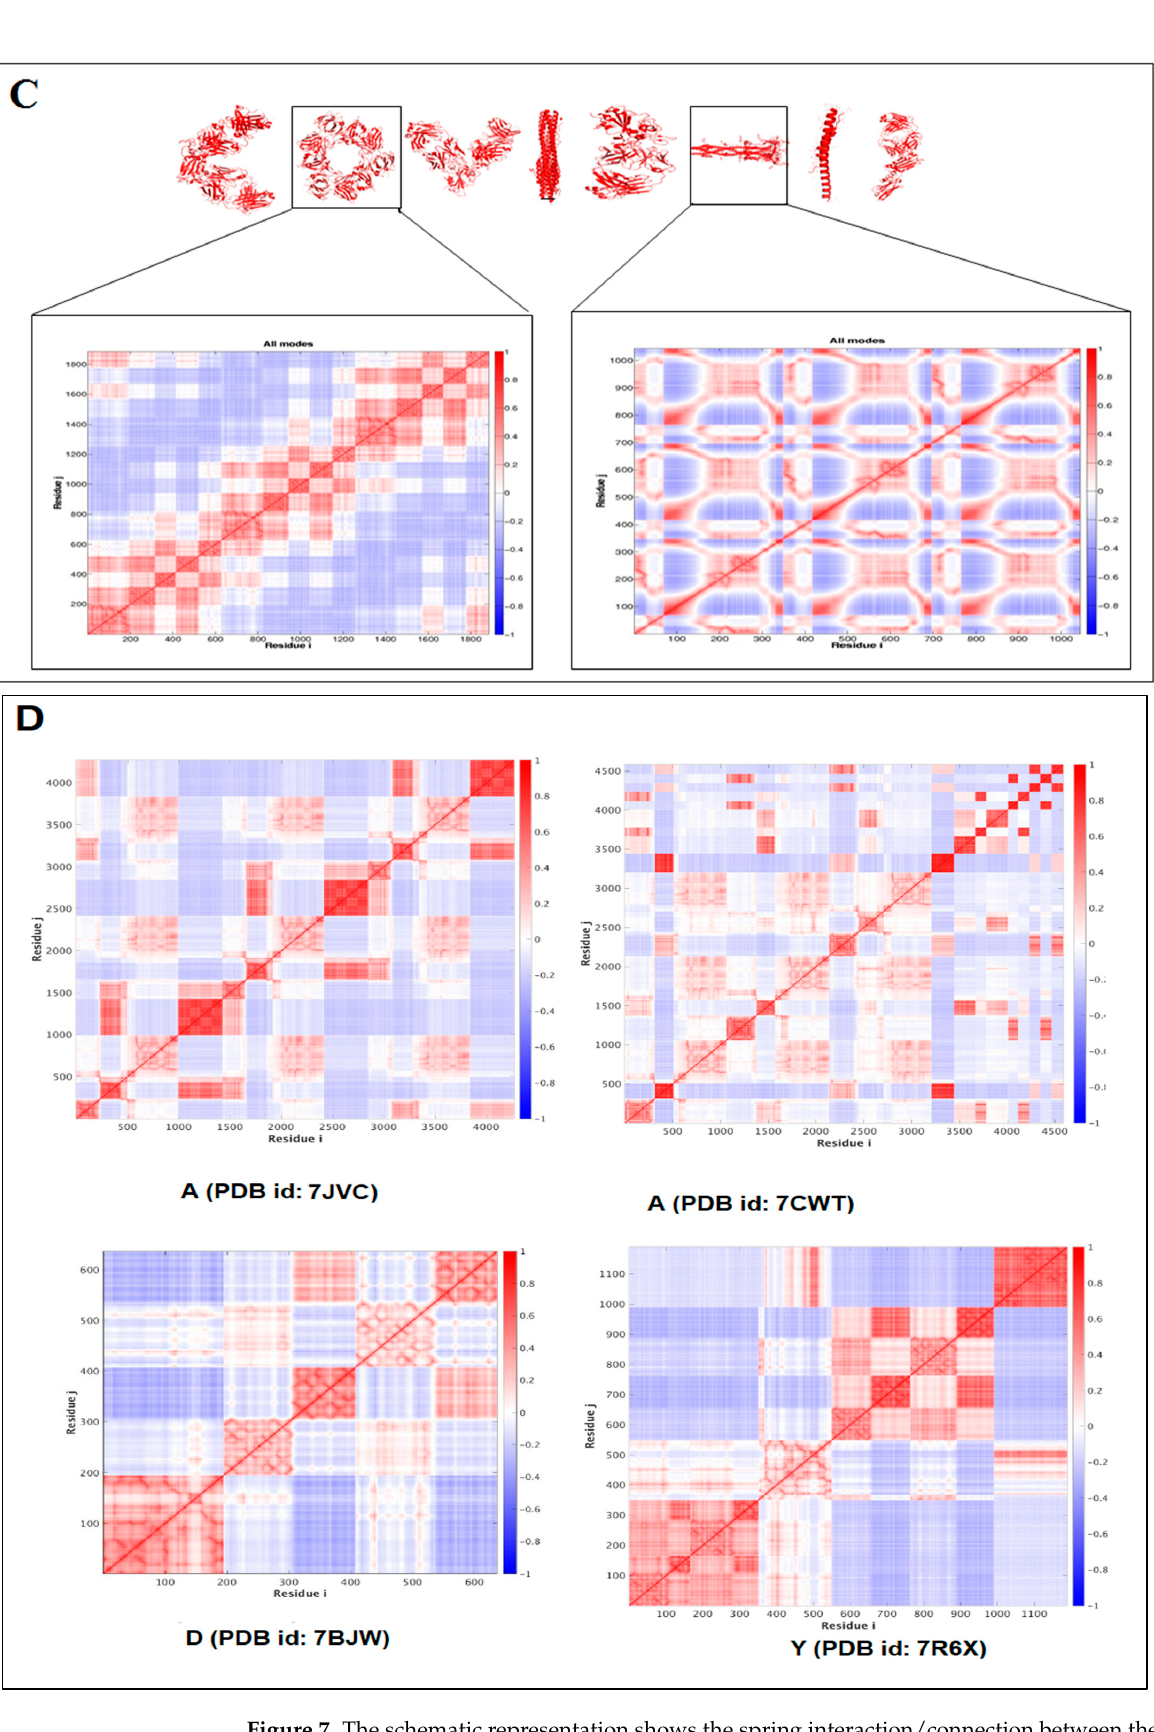
Figure 7. The schematic representation shows the spring interaction/connection between the pair of interest nodes or chains and to develop a cross-correlation (CC) map from the study of SARS-CoV-2 proteins and non-SARS CoV-2 proteins. ( A ) Schematic representation of spring in- teraction/connection between the pair of interest nodes or chains and to develop a cross-correlation (CC) map. ( B ) A cross-correlation (CC) map of 3D structures of proteins, which were used to de- velop the word “SARS-CoV-2”. ( C ) A cross-correlation (CC) map of all residues and chains of 3D structures of proteins, which were used to develop the word “COVID-19”. ( D ) A cross-correlation (CC) map of all residues and chains of 3D structures of four SARS-CoV-2 protein alphabets with antibodies/immunological or vaccine-associated roles used in this study. The study analyzed the structural pattern of 3D structures of each protein using spring interaction/connection between the pair of interest nodes or chains and to develop a cross-correlation (CC) map. Simultaneously, the study developed the CC map of 3D structures of non-SARS-CoV-2 proteins alphabets, as shown in Figure S5. The cross-correlation (CC) map shows the calculated residue interface visualized (i,j) alongside the axes in the map. Using the hitting and signal communication times, researchers can generate protein residues from communication/signaling sites related to the residue’s functionality. The functional tendency of residues can be reflected in the map. It represents sending signal